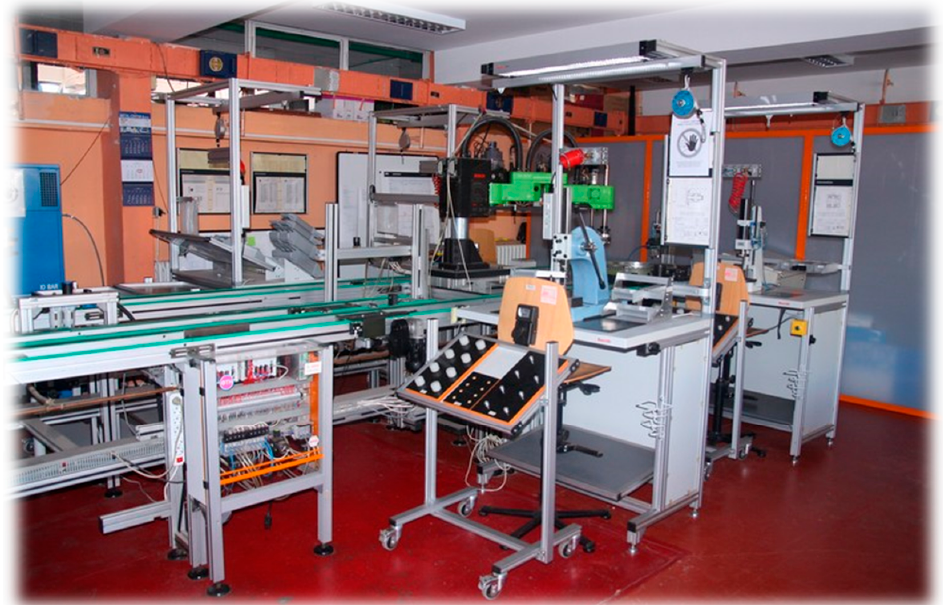
Figure 6. Industrial laboratory.